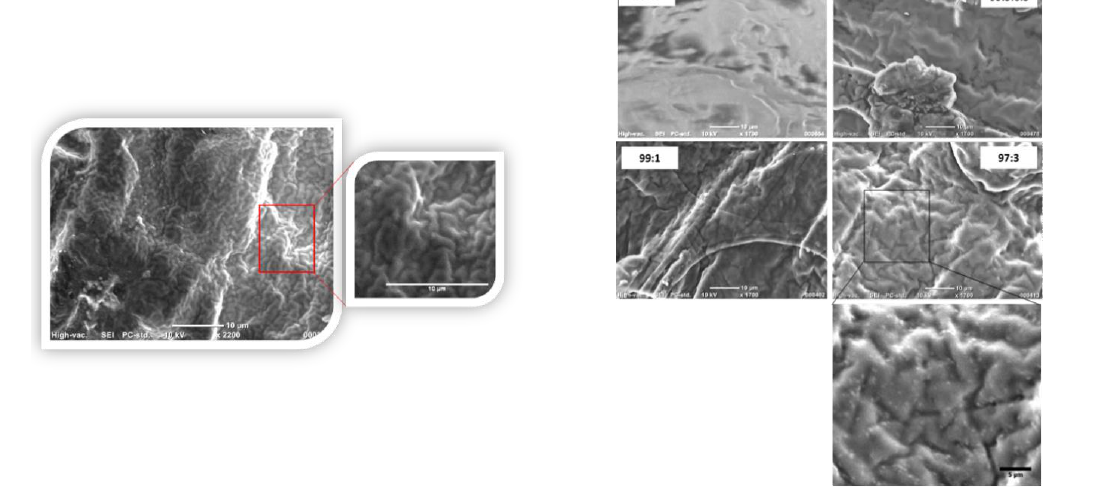
Figure 2. SEM micrographs of the pure PHB and PHB/ CpFe + nanocomposites with 0.5%, 1%, and 3% of the CpFe + moieties (right); zoomed-in image of the 97:3% of PHB/CpFe + (left) that shows the helix structure with x 2200, scale bar 10 µm.